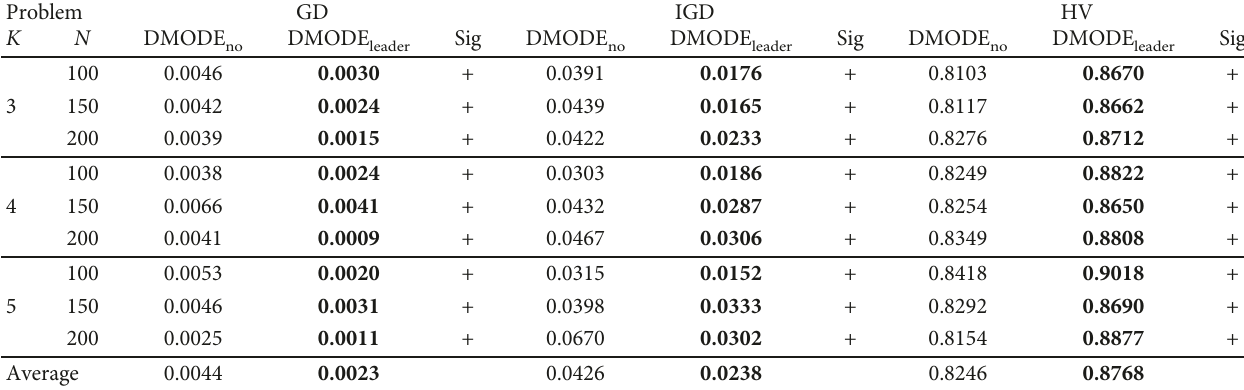
Table 1: Performance metric (GD, IGD, and HV) analysis of the mutation with adaptive leader selection. Problem